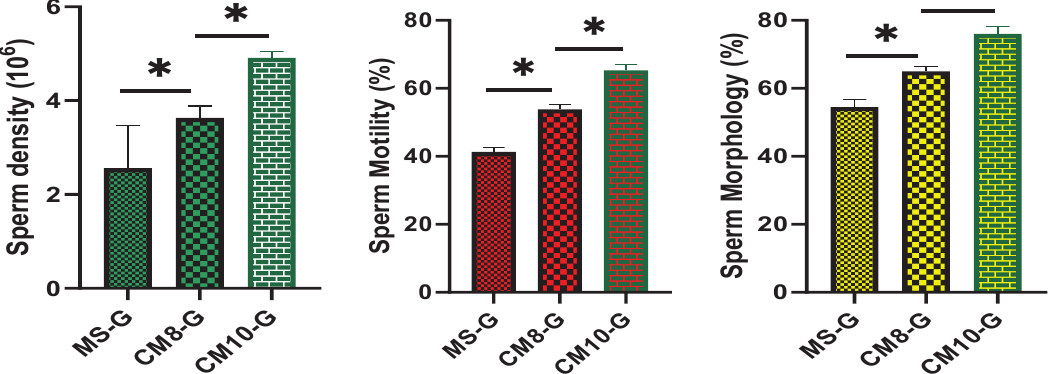
Figure 2 . Post Hoc analysis on Leydig and Sertoli cells in three groups. *p < 0.05